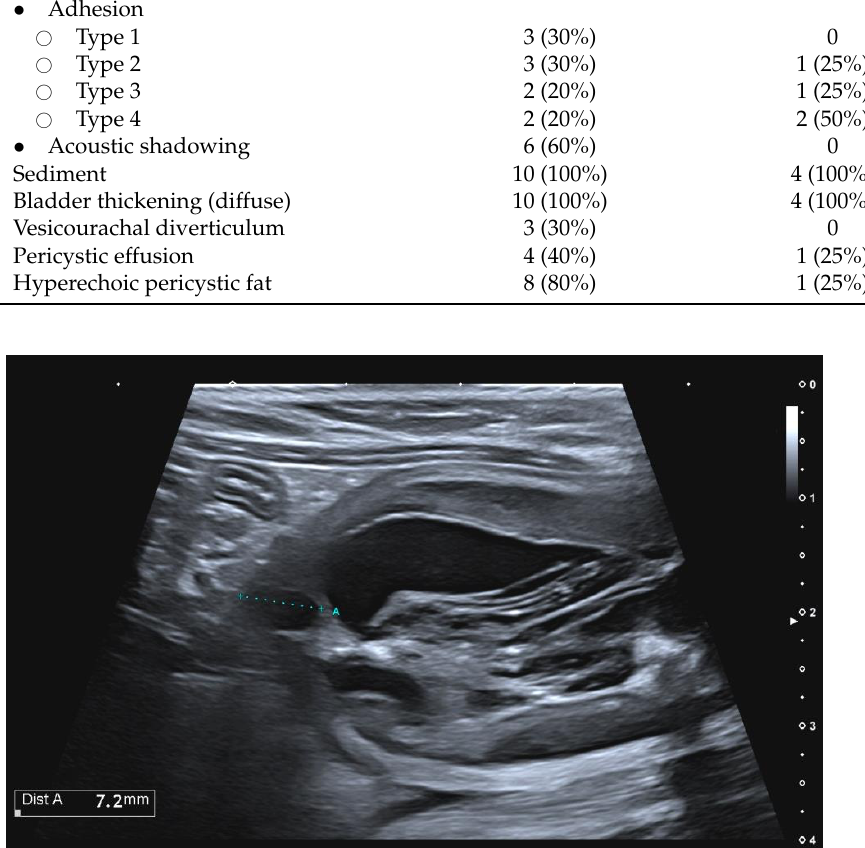
Figure 2. Longitudinal ultrasound image of the urinary bladder in a cat, showing the presence of a small, fluid-filled, anechoic structure, in the cranial bladder wall, showed by the cursor indicated with the letter “A” , consistent with intramural vesicourachal diverticulum.